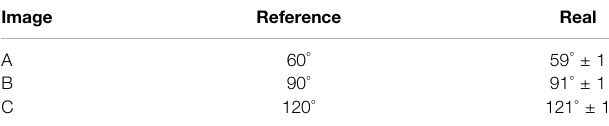
TABLE 3 | Comparison between the reference and the printed angle